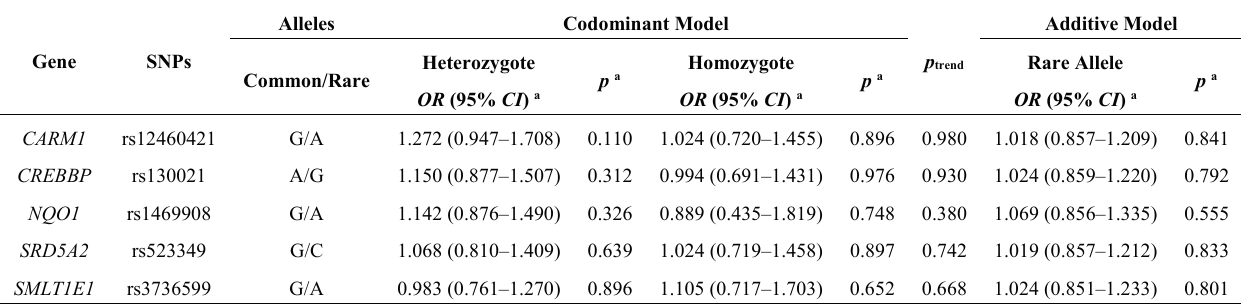
Table 5. Single SNPs in estrogen-signaling regulatory enzymes and association with breast